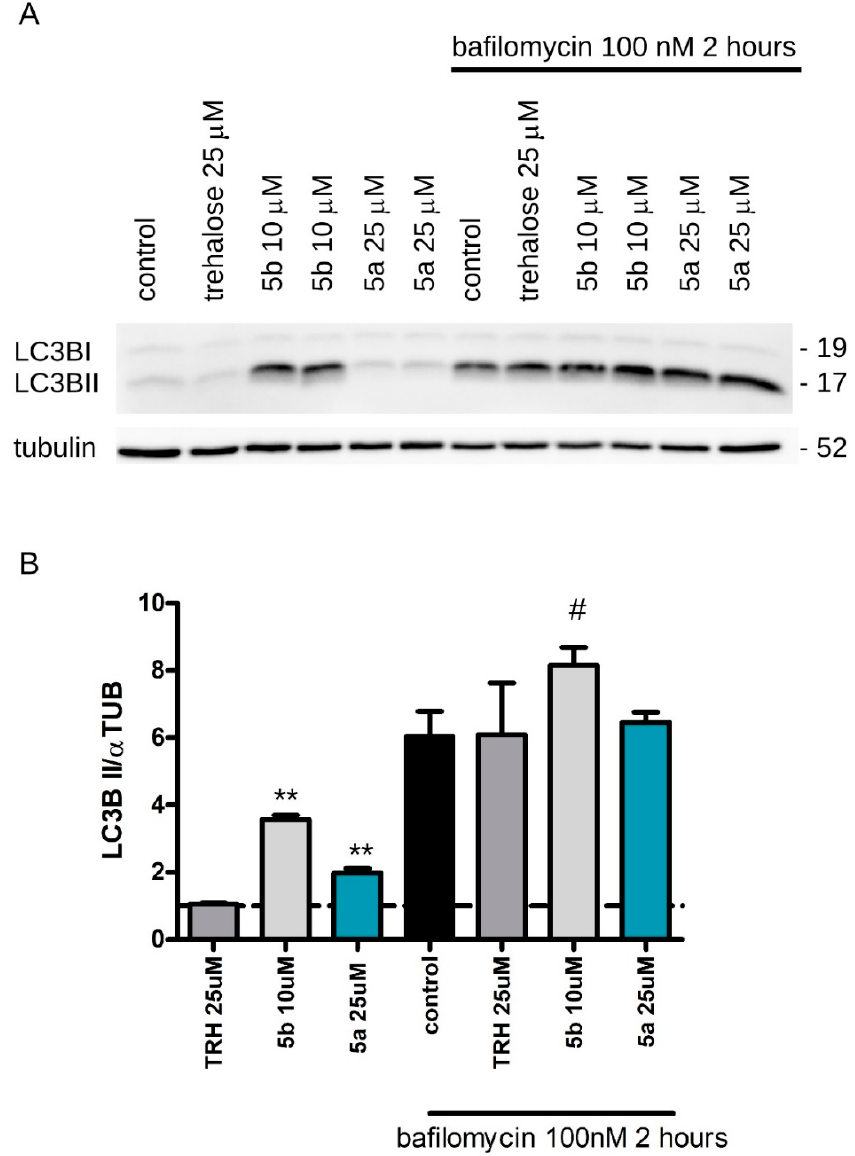
Figure 4. Characterization of the effects of trehalose and NAs 5a and 5b on autophagy. We assessed LC3B conversion upon compound treatment by Western blotting. ( A ) Evaluation of autophagy induction in HeLa cells treated for 24 h with 25 µ M trehalose, 25 µ M 5a and 10 µ M 5b . During the last 2 h of treatment, we added the known lysosomal blocker bafilomycin (100 nM, 2 h). Upon treatment, we analyzed tubulin and LC3BII levels by Western blotting. ( B ) The graph shows LC3BII amounts expressed as fold over α -tubulin. Data are expressed as mean ± S.E.; ** p < 0.01 vs. control, # p < 0.05 vs. control + bafilomycin, n = 8–10.